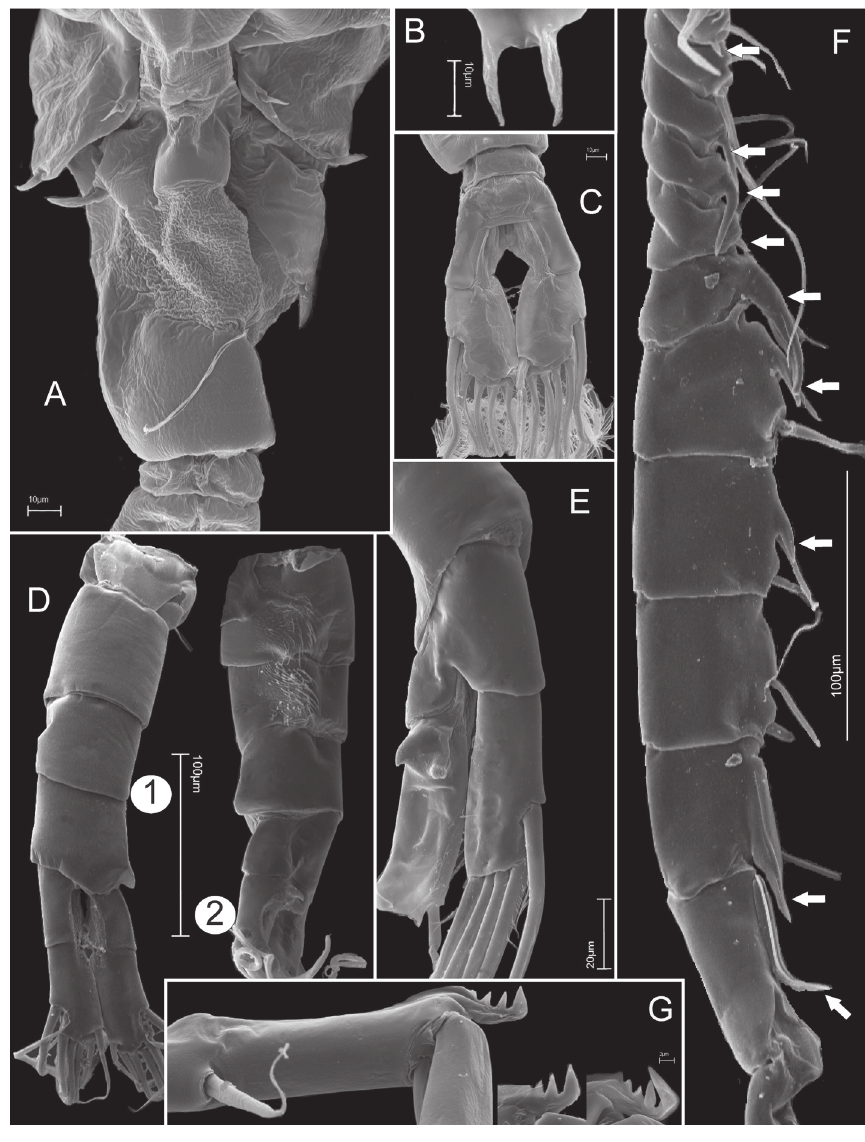
Figure 4. Mongolodiaptomus loeiensis sp. n., SEM photographs. Female ( A–C ): A pediger 5 and genital somite, dorsal view B rostrum, frontal view C urosomite 2, anal somite and caudal rami, dorsal view; Male ( D–G ): D1 urosome in dorsal view D2 urosome in ventro-lateral view E anal somite and caudal rami, ventral view F the right antennule segments 8–18 (white arrows point to spines) G spinous process on right antennule segment